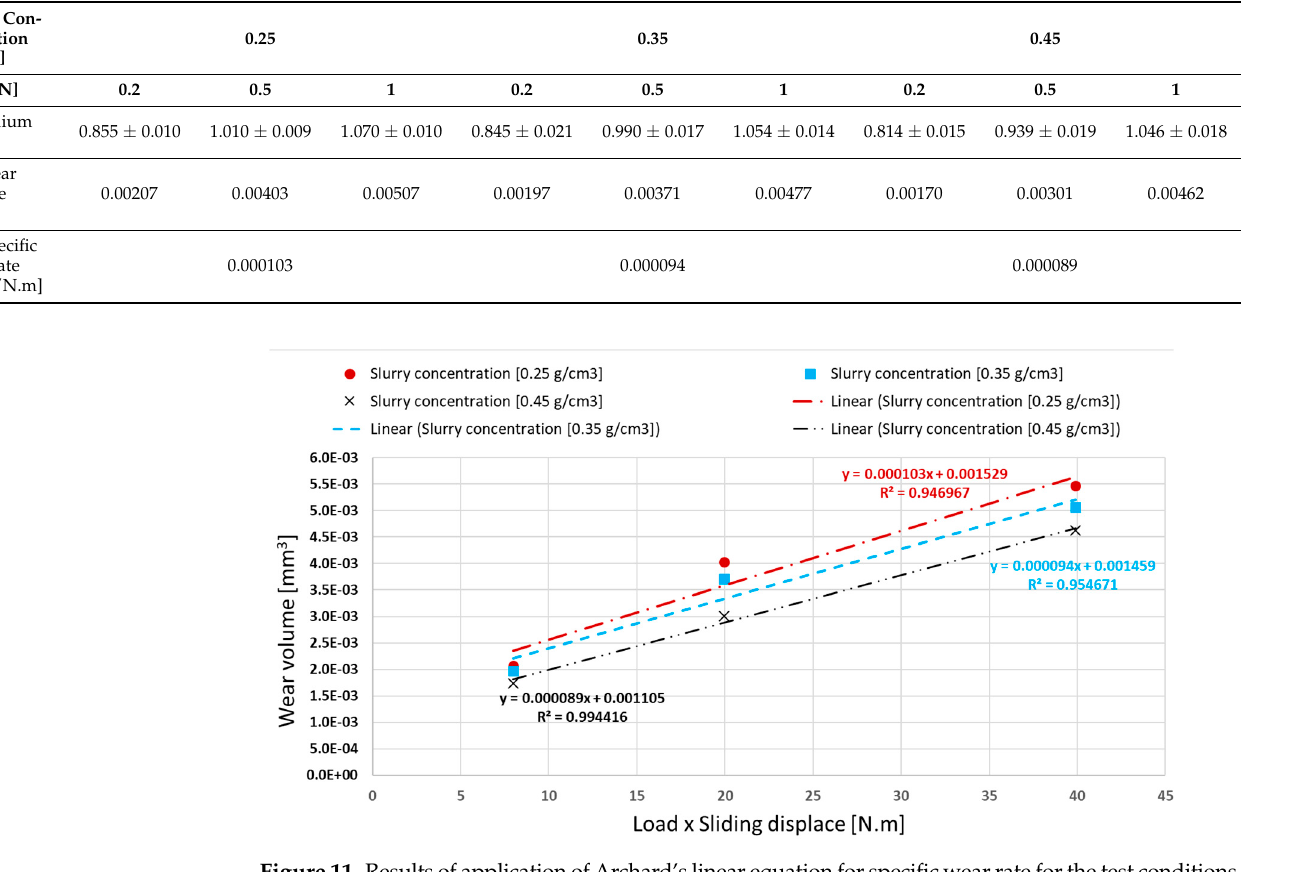
Figure 12. Roughness parameter trends (Sa) for different abrasive mass loads such as 0.2 N, 0.5 N and 1N. The scars produced by the micro-abrasion setup were characterized by SEM to identify the dominant wear mechanisms. Figure 13a,b,c are the images collected in SEM for a load of 0.2 N and for the abrasive slurry concentrations of 0.25 g/cm 3 , 0.35 g/cm 3 , and